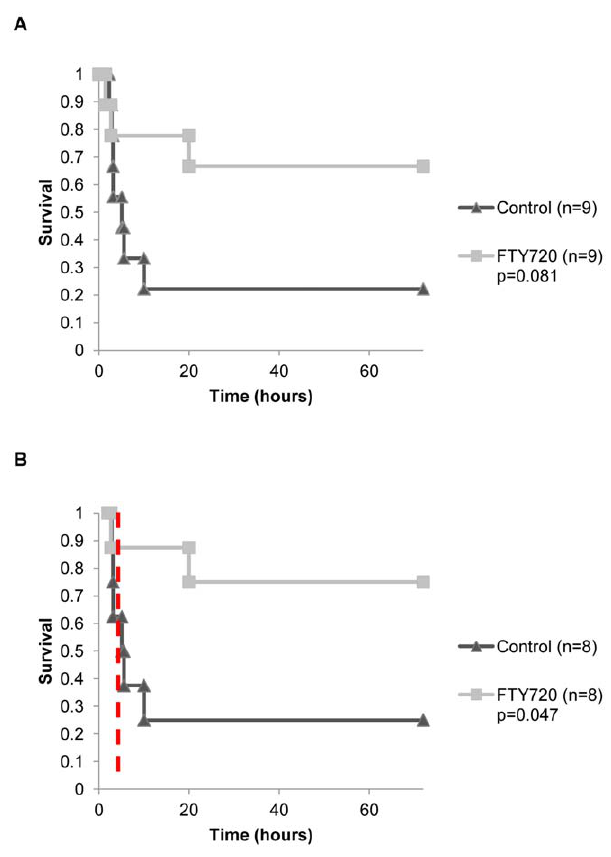
Figure 3. Kaplan-Meier survival curve for experimental groups versus control with log-rank test for statistical comparison. a ) Overall survival. b ) Reperfusion period survival. Dashed red line indicates end of hemorrhage and beginning of reperfusion period.